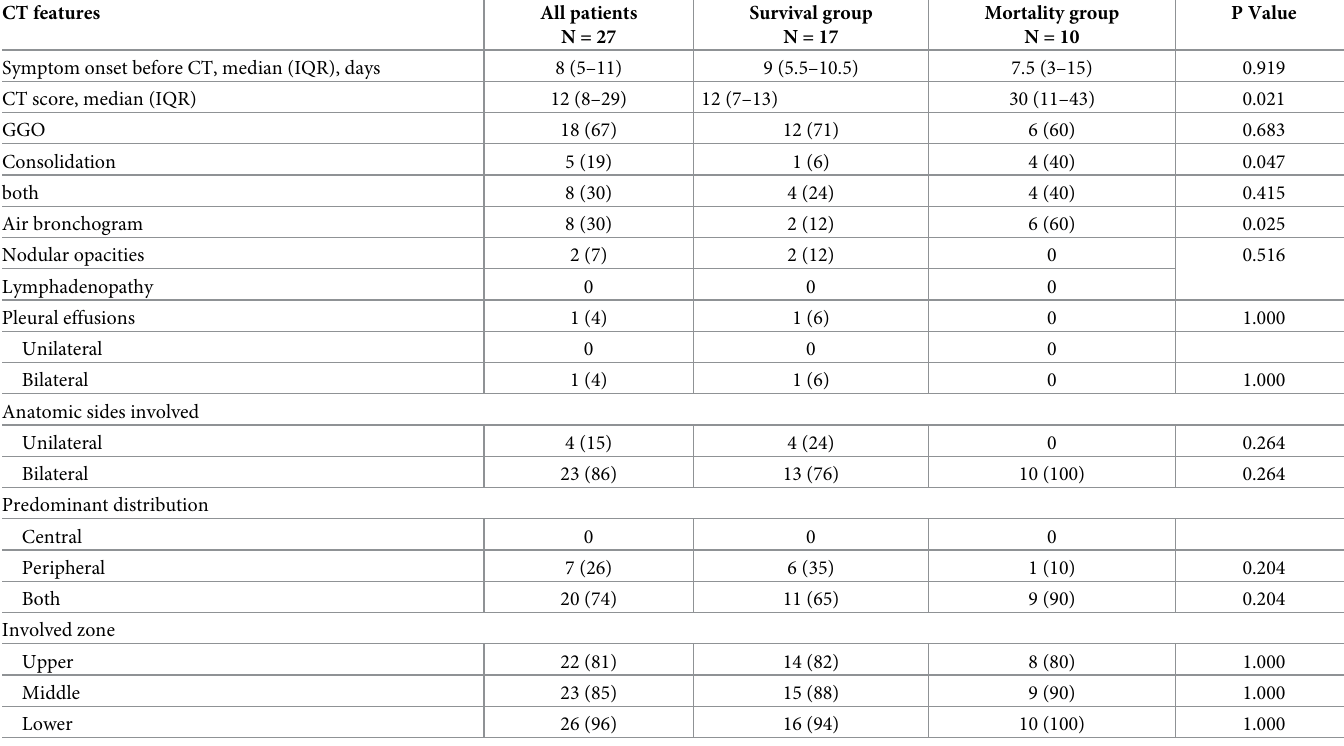
Table 2. CT features in mortality and survival